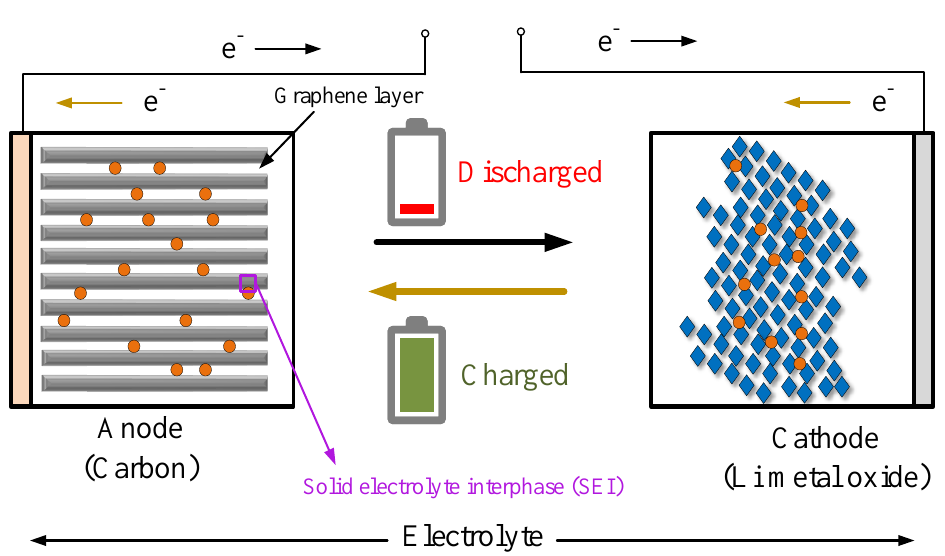
Figure 14. The schematic representation of electrochemical Li-ion battery cell